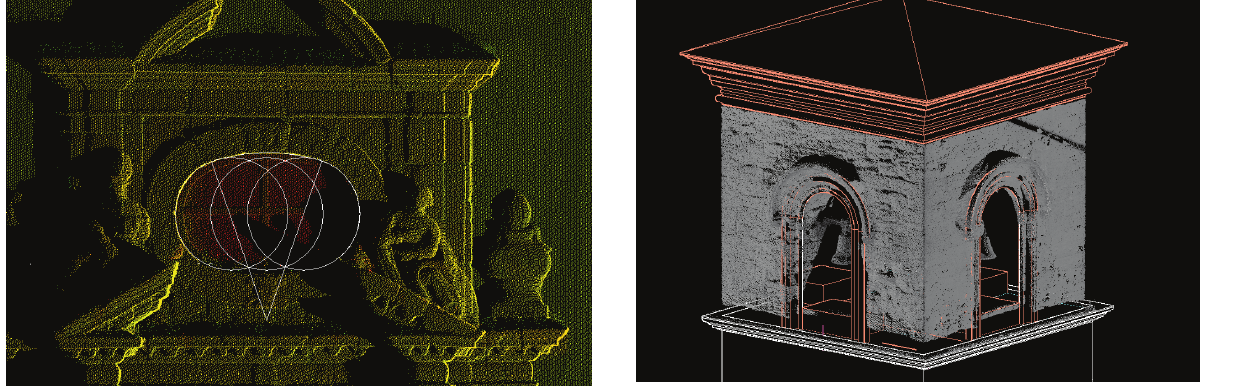
Figure 14. Geometric construction applied to the oval-shaped window